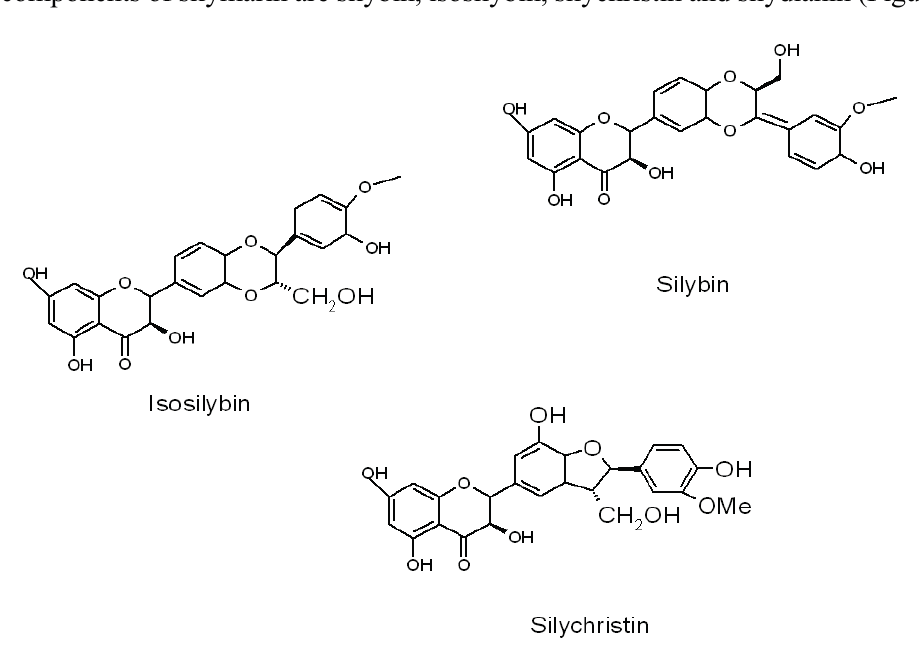
Figure 1. Structure of silymarin